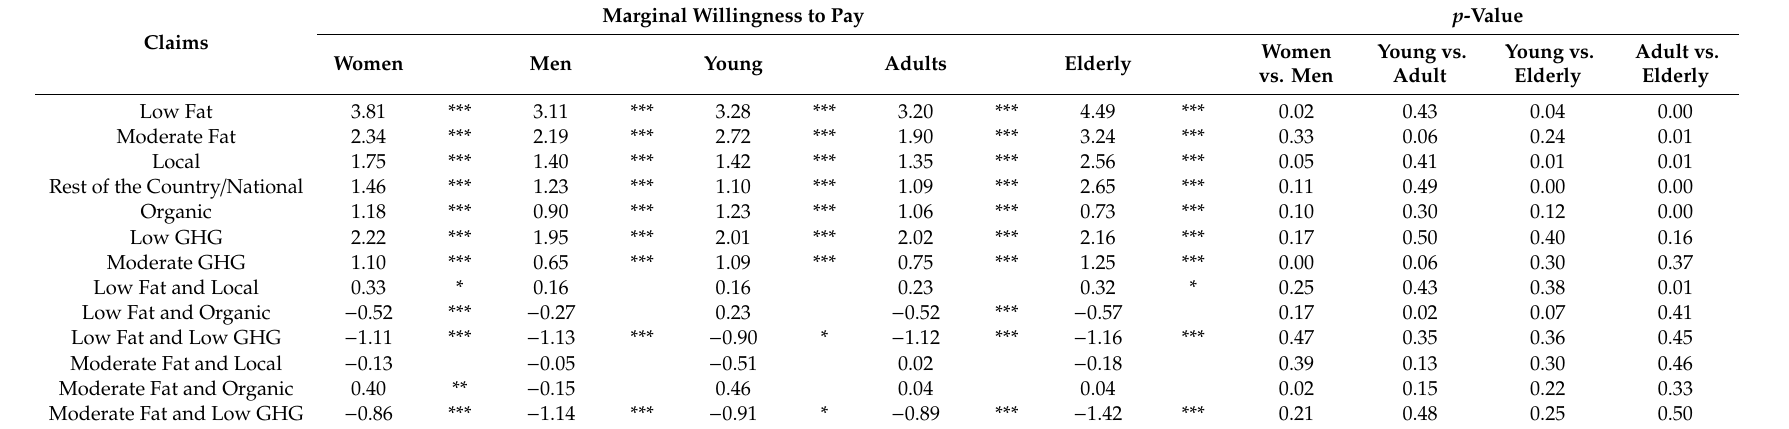
Table 4. Heterogeneity of consumers’